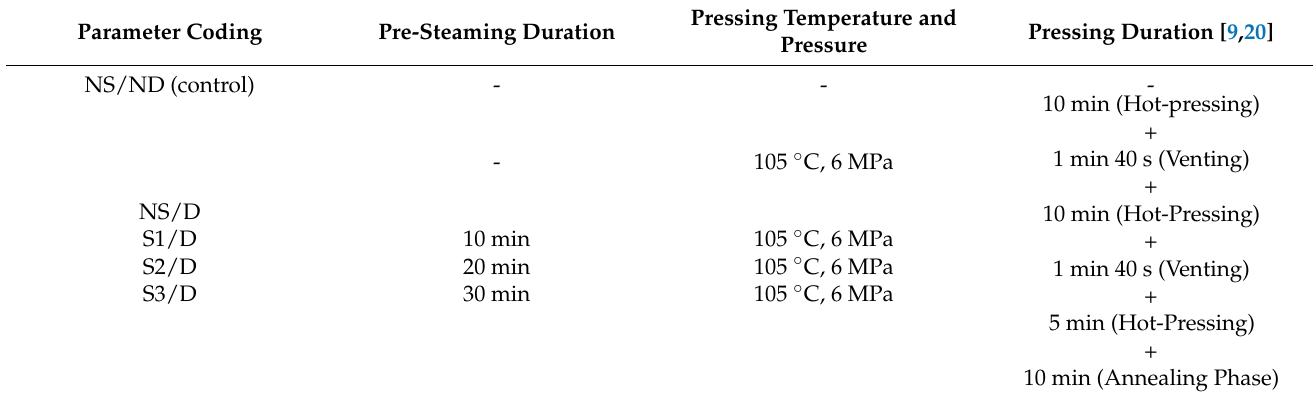
Table 1. Different settings for viscoelastic-thermal compression (VTC) treatment. Parameter